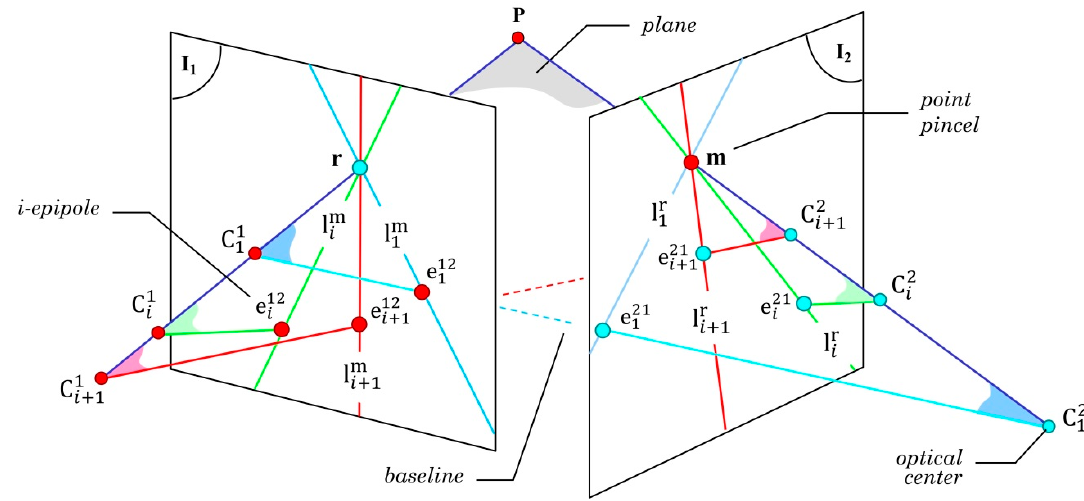
Figure 4. The k subsets of epipolar lines from multiple optical centers.